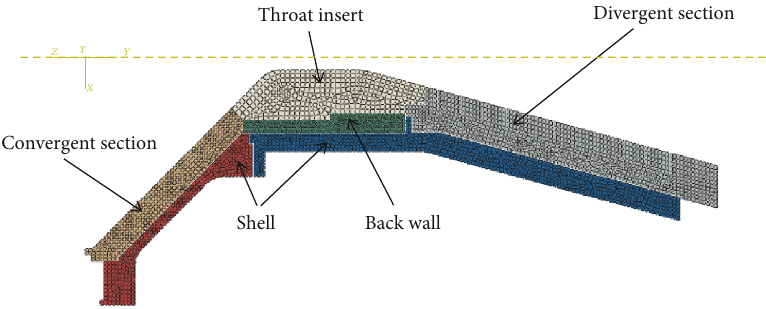
Figure 5: The fi nite element model of one solid rocket motor